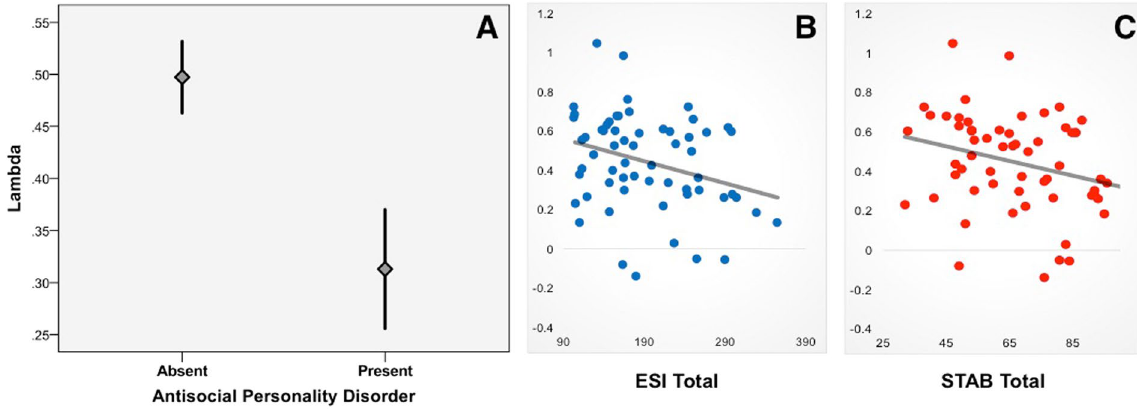
Figure 3. APD Diagnosis and Antisocial Traits are Linked to Blunted Ambiguity Aversion. Scatterplots show lower ambiguity aversion in APD (A; mean + / − 1 SEM), and negative correlations between ambiguity aversion and ESI ( B ) and STAB ( C )